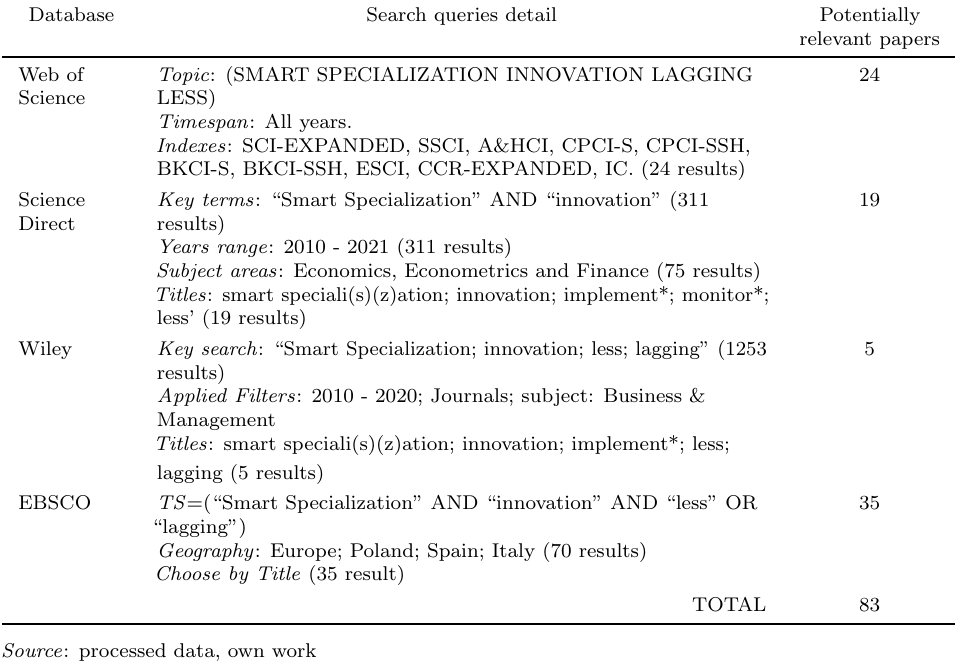
Table 1: Search queries process